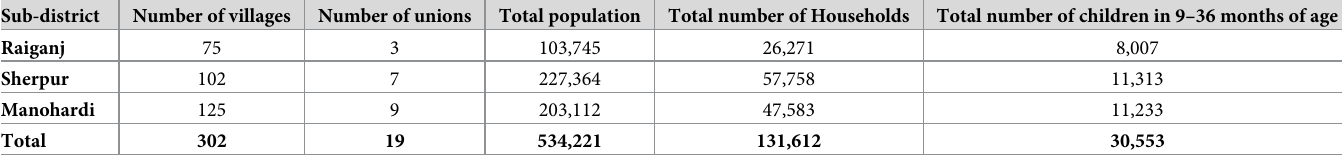
Table 1. Target population for playpen intervention in the baseline